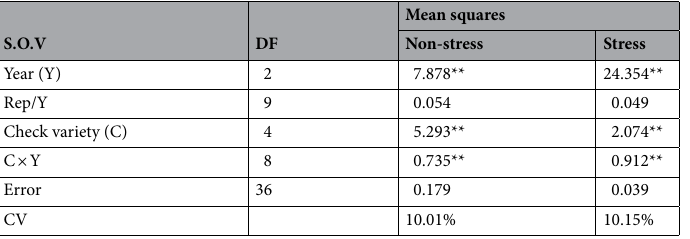
Table 1. Summary of combined analysis of the grain yield (GY) of five check varieties as RCBD design during 3 years with four replication (Rep) under non-stress and drought stress conditions across 3 years 2017–2019. **Significant at 0.01 probably level by F